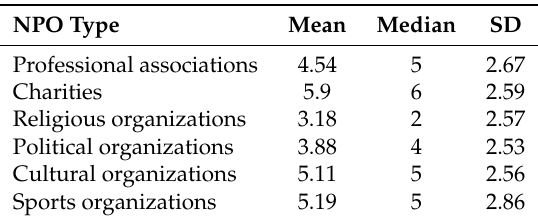
Table A1. Descriptives of general interest in NPOs.